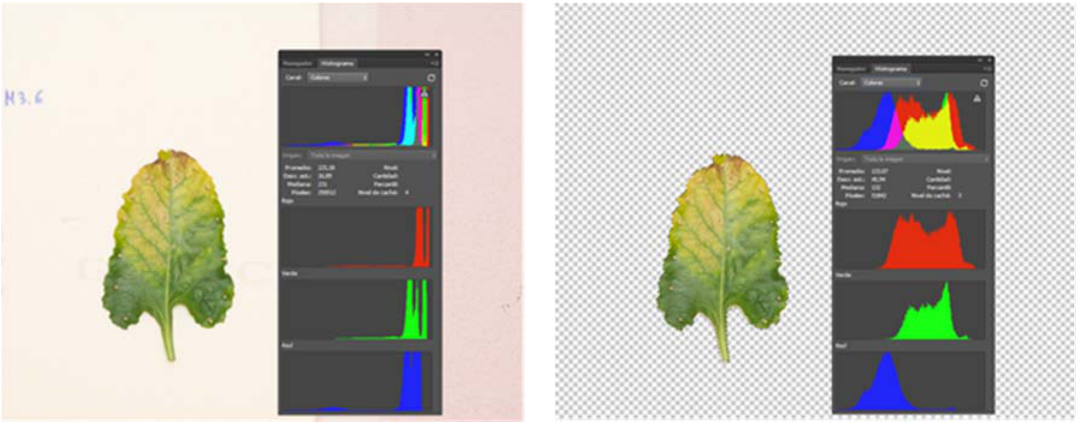
Figure 2. ( Left ) Nonprocessed photograph. Histogram shows RGB levels of the entire photograph. ( Right ) Same photograph after background removal. The histogram only shows the leaf RGB levels.